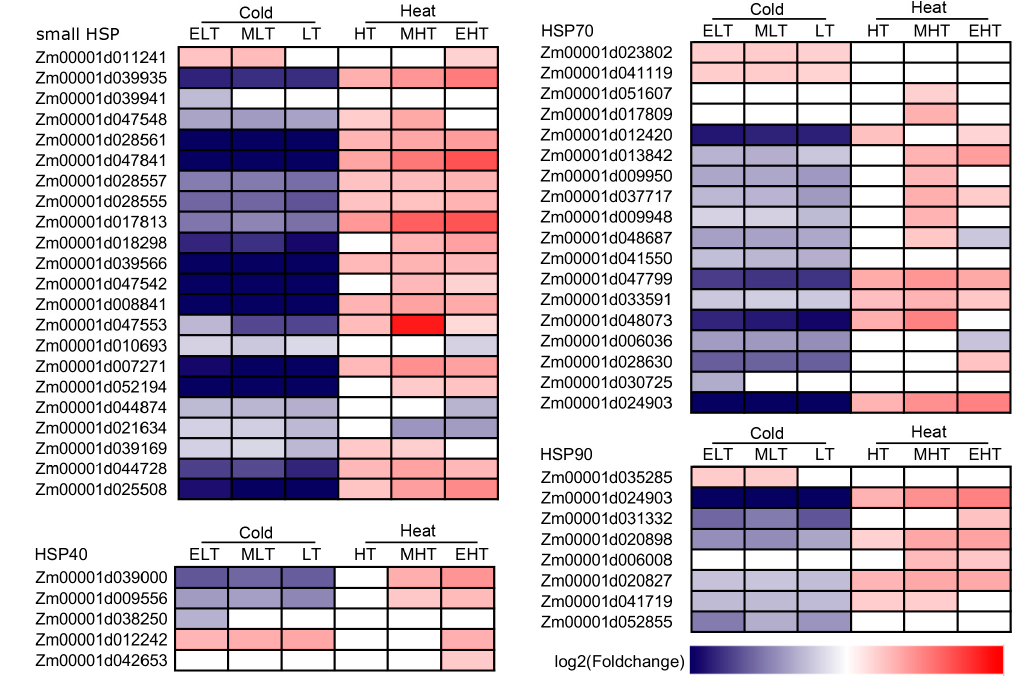
Figure 6. Heatmap of the differentially expressed genes encoding the members of HSP family in response to temperature stress. ELT, extreme low temperature, 4 °C; MLT, medium low temperature, 10 °C; LT, low temperature, 16 °C; NT, normal temperature, 25 °C; HT, high temperature, 37 °C; MHT, medium high temperature, 42 °C; and EHT, extreme high temperature, 48 °C.